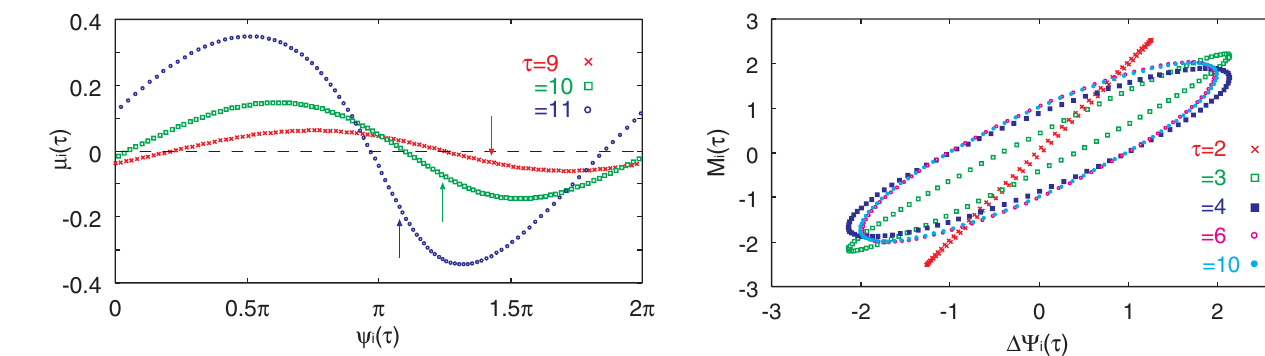
FIG. 3. (Color) Electron distributions in a normalized phase (cid:2) (cid:6) (cid:4) given by Eq. (15) and M (cid:2) (cid:6) (cid:4) given by plane of (cid:1)(cid:3) i i Eq. (16) for (cid:6) (cid:1) 2 ; 3 ; 4 ; 6 ; 10 . The center of the electron micro- (cid:2) (cid:6) (cid:4) ; M (cid:2) (cid:6) (cid:4)(cid:6) (cid:1) (cid:2) 0 ; (cid:7) 1 (cid:4) when (cid:6) (cid:10) 4 . bunch is located at (cid:5) (cid:1)(cid:3) i i (cid:2) (cid:6) (cid:4) 2 (cid:3) M (cid:2) (cid:6) (cid:4) 2 (cid:7) The constant ellipse seen in Fig. 3 is (cid:1)(cid:3) p i i (cid:1)(cid:1)(cid:1) (cid:2) (cid:6) (cid:4) M (cid:2) (cid:6) (cid:4) (cid:1) 1 when (cid:6) (cid:10) 4 . The ellipse rotates 3 (cid:1)(cid:3) i i clockwise as (cid:9) (cid:2) (cid:6) (cid:4) increases linearly with (cid:6) , while its size remains constant. This shows that the electron micro-